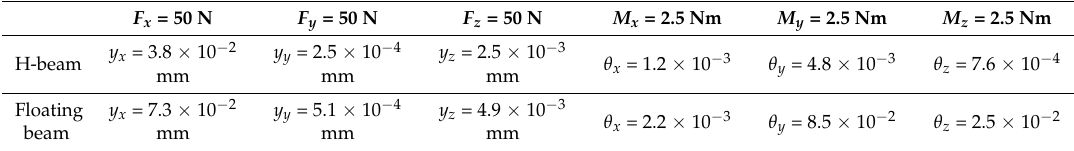
Table 1. Finite element simulation results of H-beam and floating